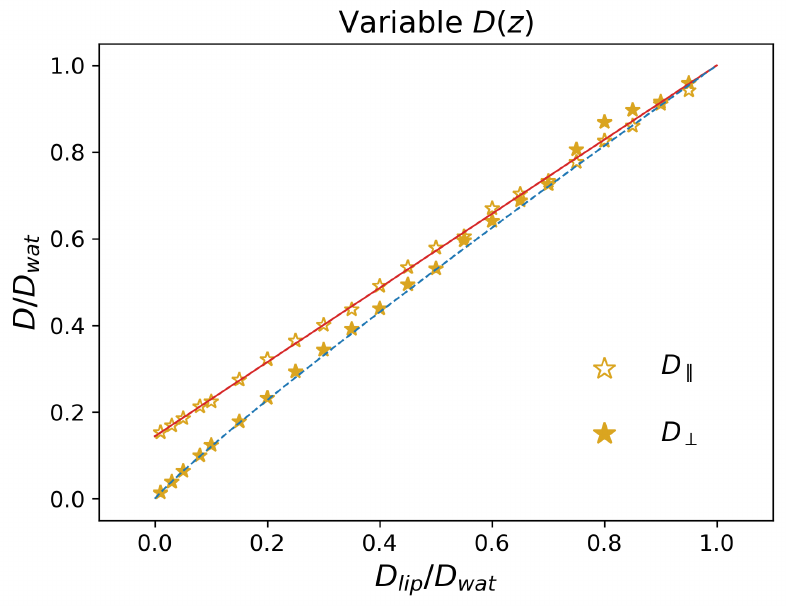
Figure 4. Effective diffusion coefficients in a system with position-dependent D ( z ) and no external potential. The red continuous line is the prediction from Equation (12). The blue dashed line corresponds to a fit of the simulation data by a power